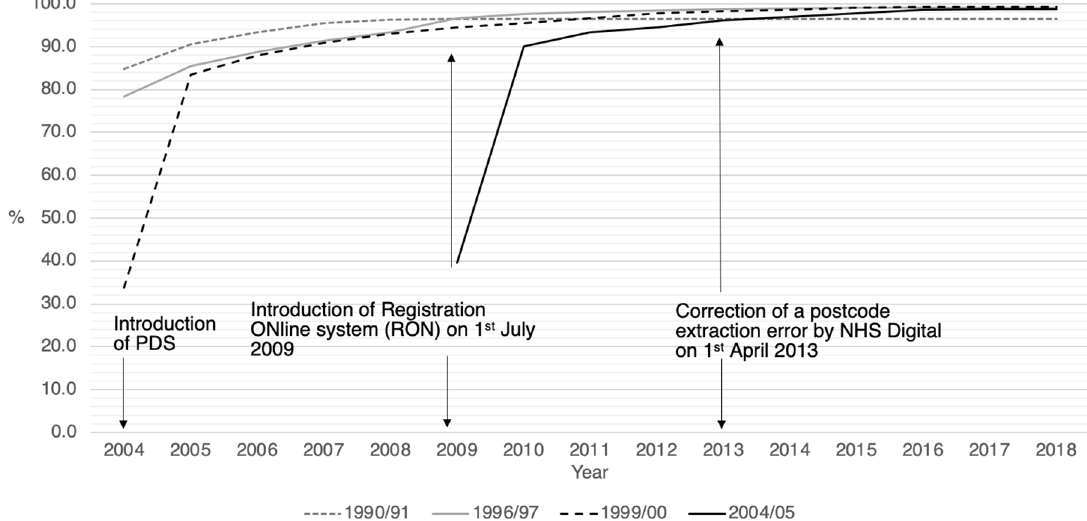
Figure 4: Cumulative percentage of records linked in stage 1 (NPD to PDS; y axis) by academic year in spring census (x